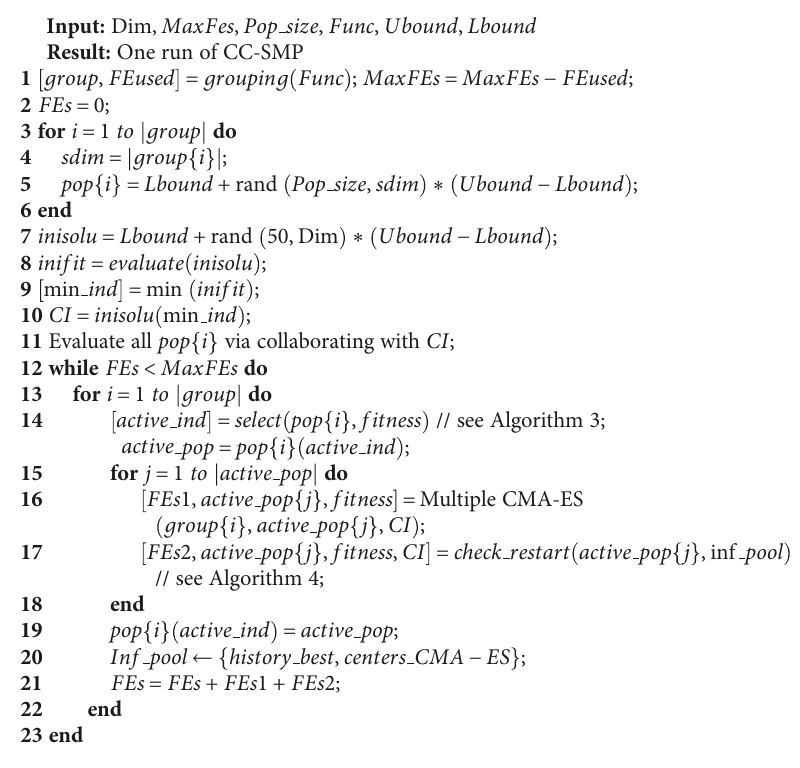
Algorithm 2: Framework of CC-SMP.